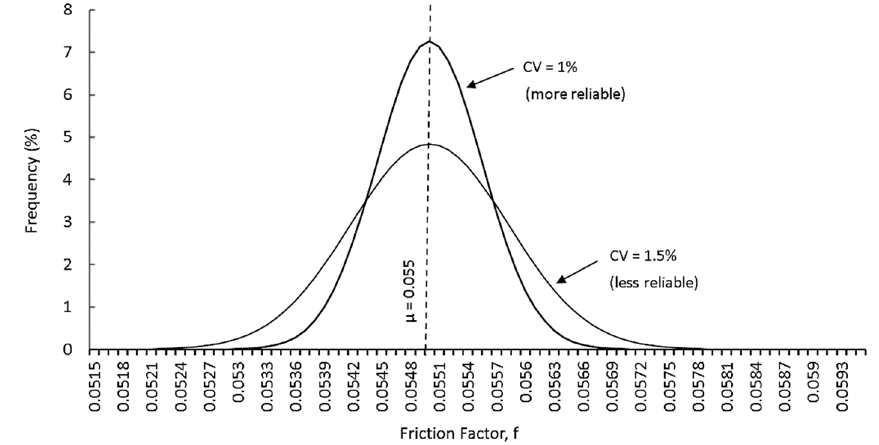
Figure 1. Definition of